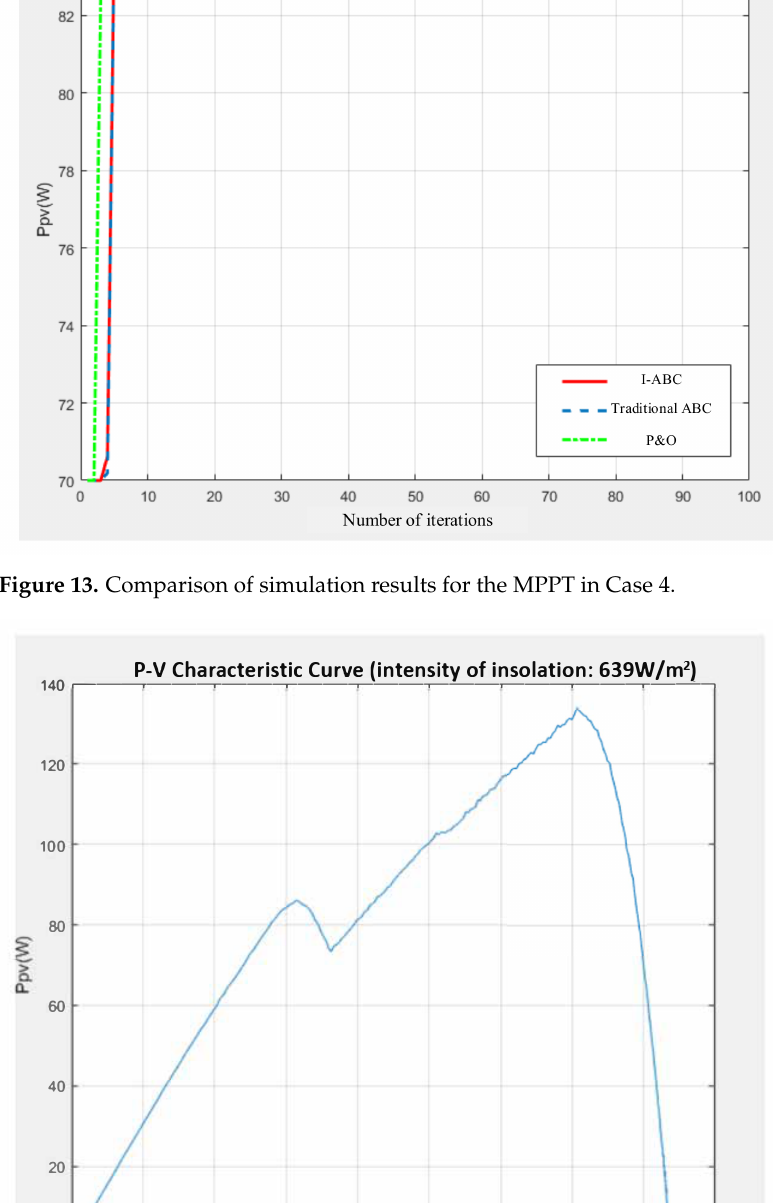
Figure 14. P-V characteristic curve of the photovoltaic module array in Case 5 (with double-peak